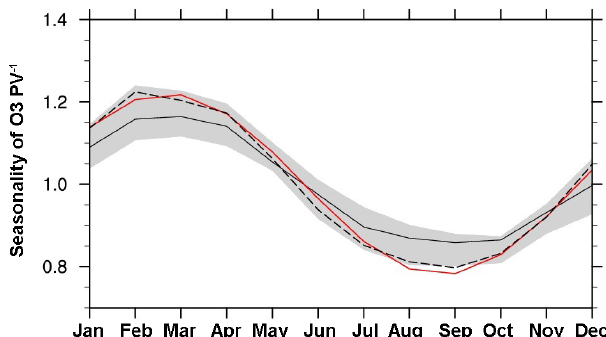
Figure 3. Seasonality of O 3 / PV (Annual mean = 1, selected pres- sure < 60hPa, black solid line = observed mean at all sites, grey shadows represent 25 to 75% of observed records, black dash line = observed mean at sites at latitudes > 40 ◦ N, red line = fitted by